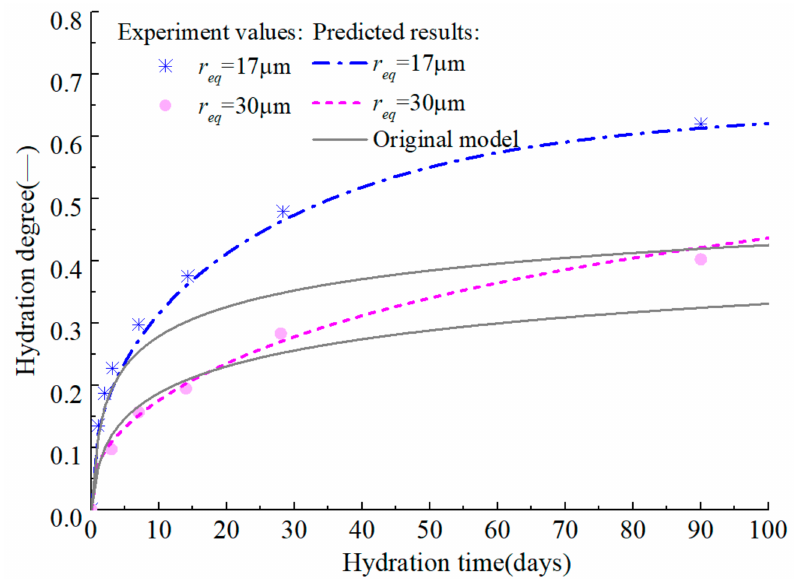
Figure 7. Test values and prediction curves of long-term hydration degree of